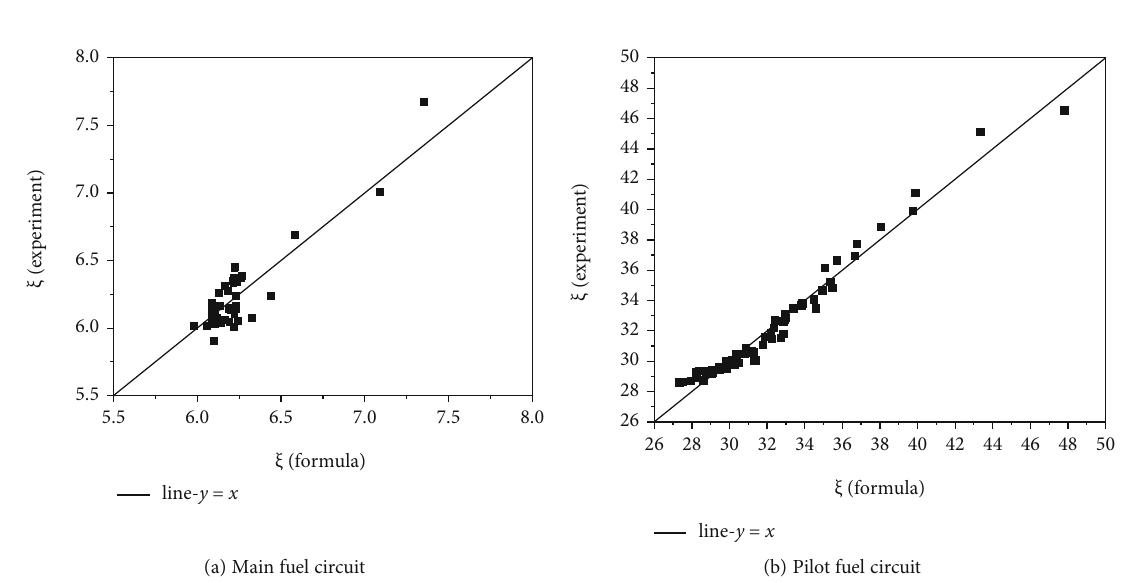
Figure 21: Relative error of empirical